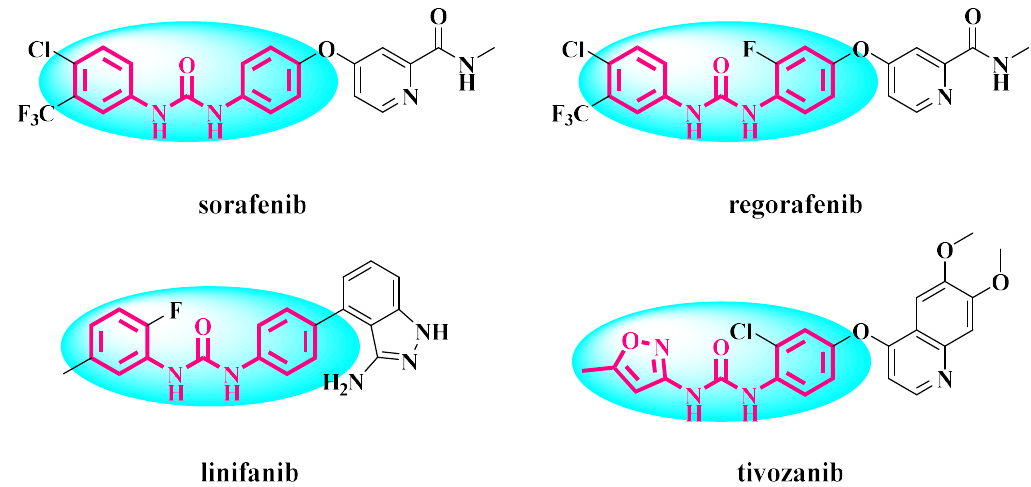
Figure 3. Some anticancer drugs of the diaryl urea moiety.